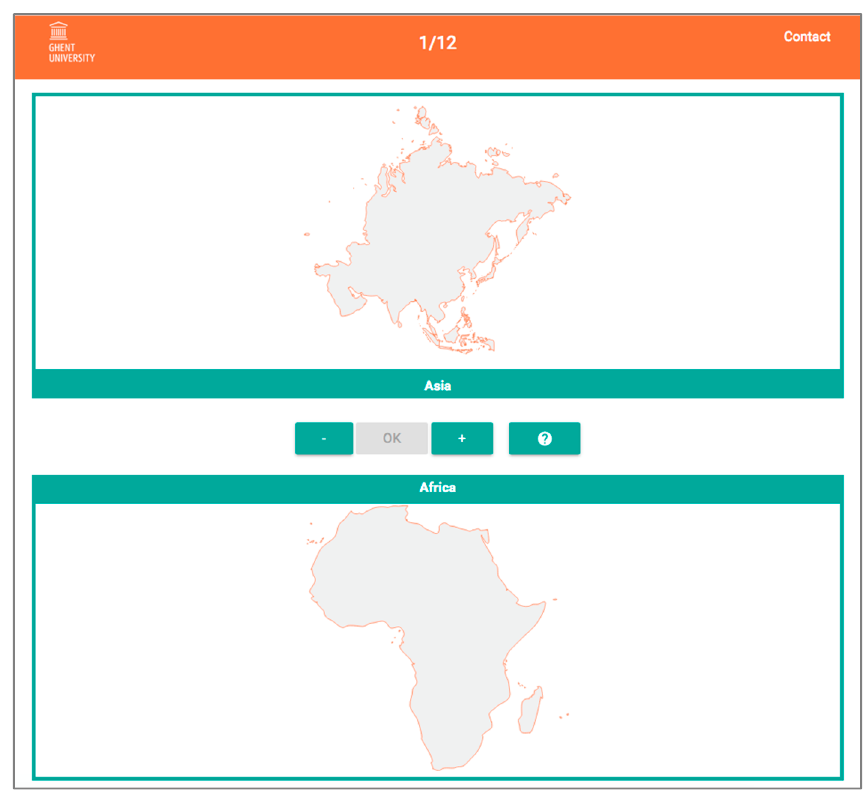
Figure 4. An example of the initial interface with as ‘test region 1’ Asia and as ‘test region 2’ Africa. The height of Africa corresponds with the maximum height of the box, while the width of Asia fits in the maximum width of the box.